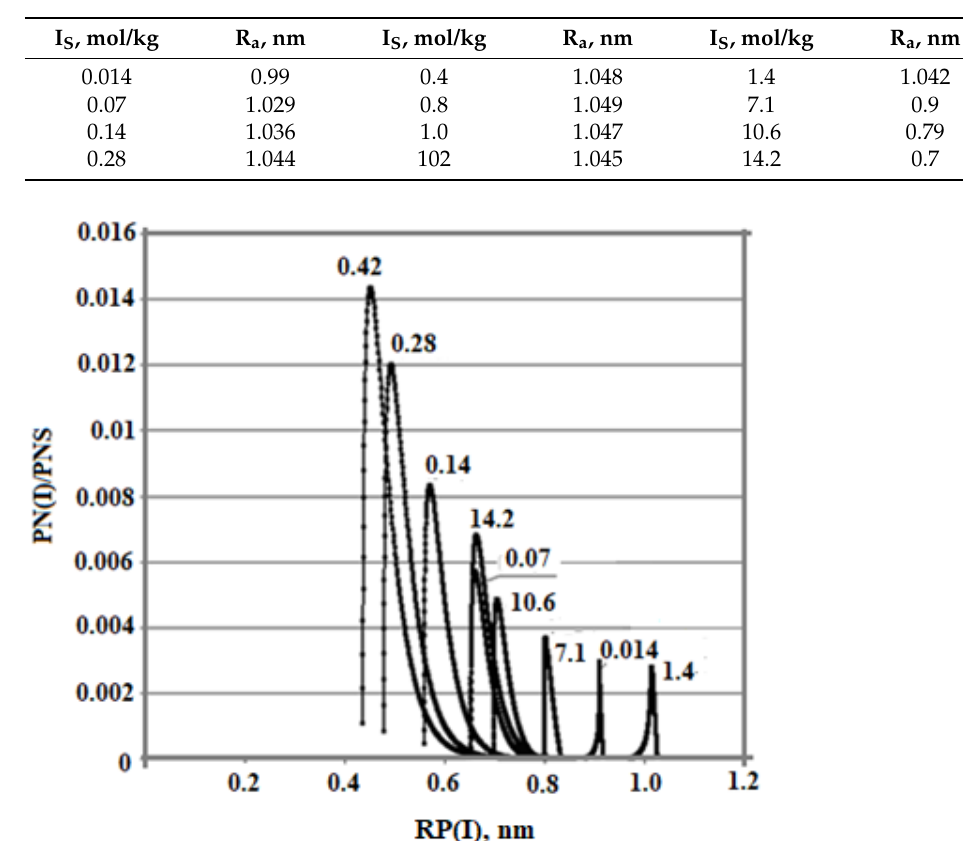
Mutnovsky hydrothermal field at C s = 700 mg/kg and pH = 8.0; taun0 was taken to be